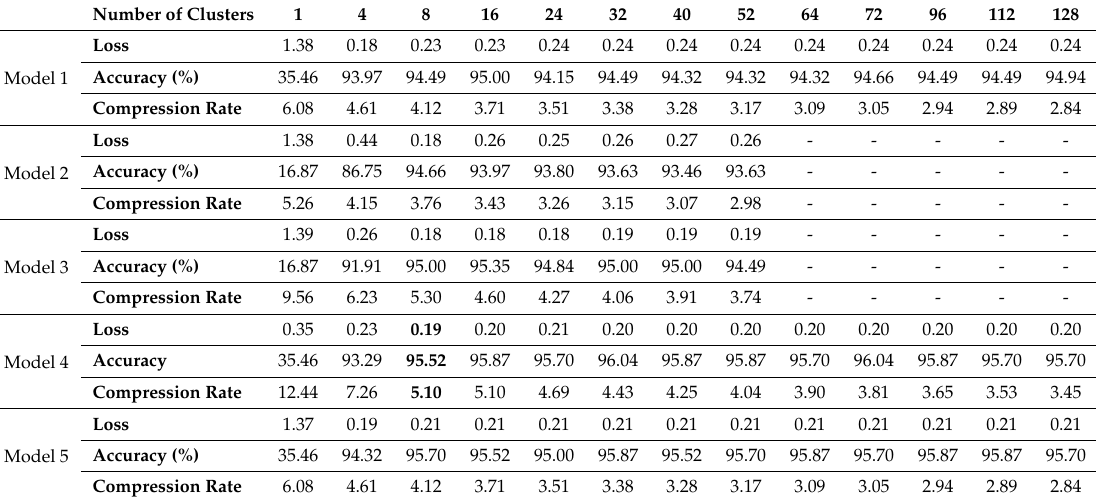
Table 10. Results for scalar quantization on fully connected layers